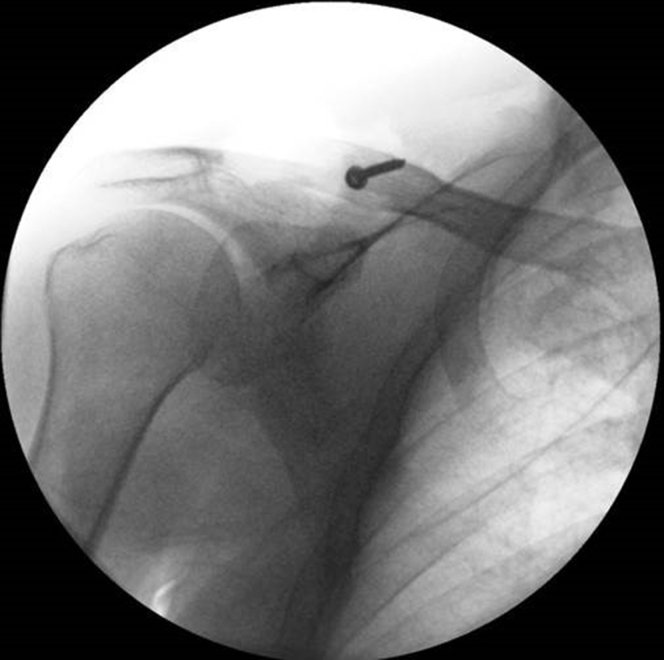
Fluoroscopic image after placement of LockDown device.